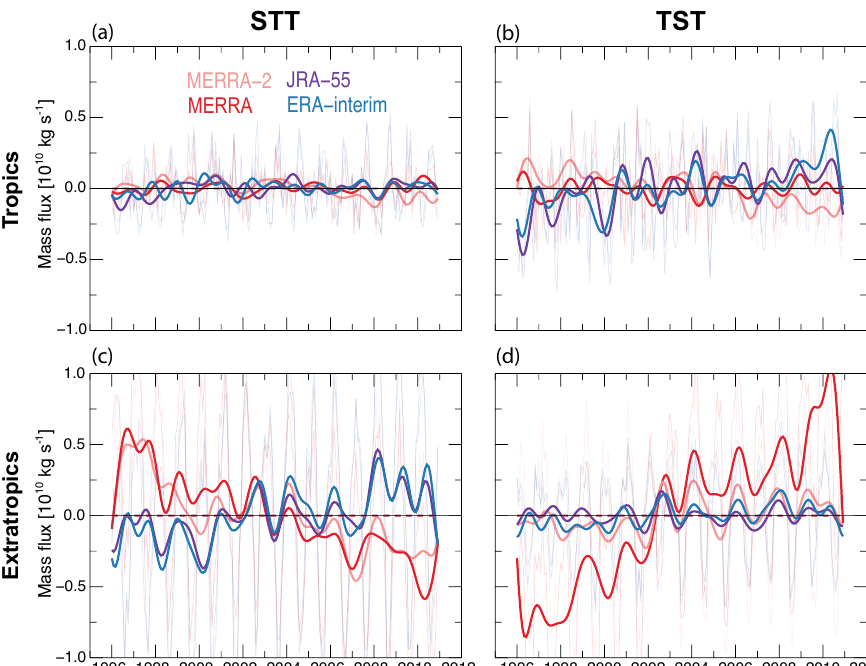
Figure 14. The same as in Fig. 13 but for STE in the (top) tropics and (bottom) extratropics.